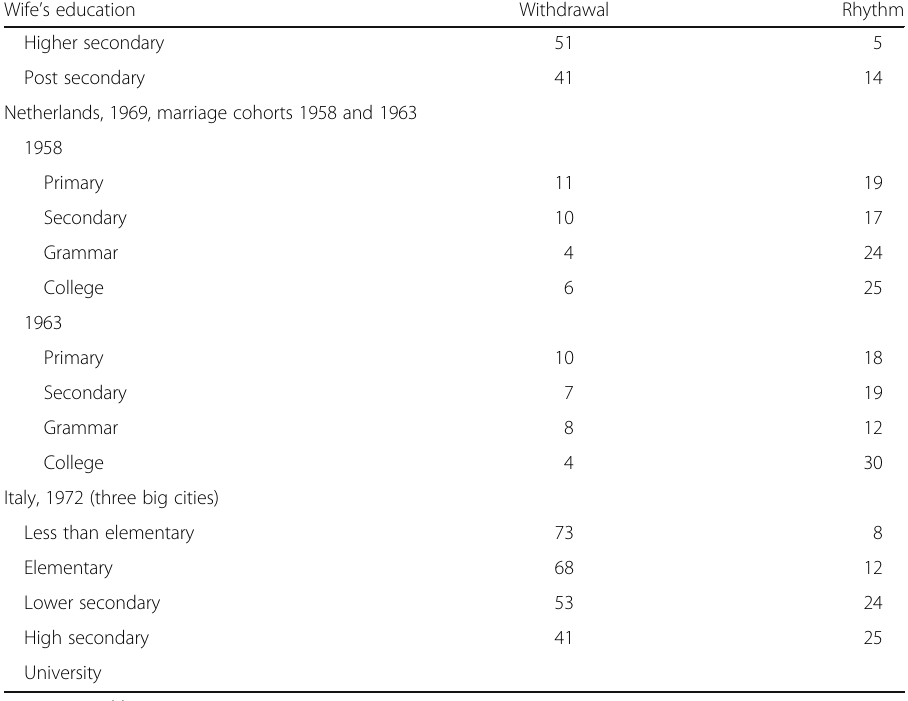
Table 10 Percent of users, currently using withdrawal or rhythm according to wife ’ s education (Continued)